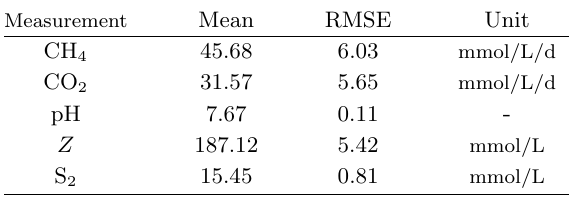
Table 9: RMSE of error (deviation) between exper- imental and simulated measurements with adapted model for estimation data set